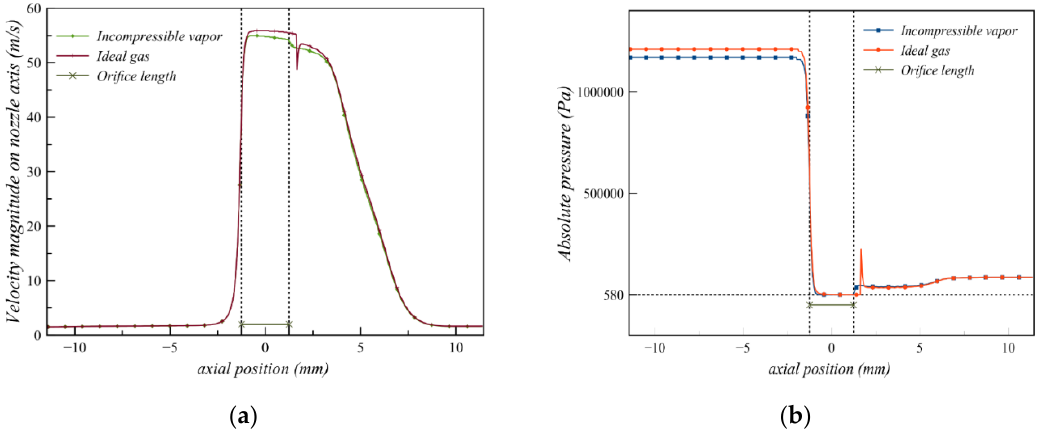
Figure 16. Predicted pressure and velocity profiles on the nozzle axis. ( a ) Pressure profile, ( b ) velocity profile. To further investigate the formation of the shockwave, local sonic speeds in the liquid phase, , the vapor phase, , and the mixture phase (cavitation region), and the flow velocity magnitude 𝑎𝑎 𝑙𝑙 𝑎𝑎 𝑣𝑣 𝑎𝑎 𝑚𝑚 on the nozzle axis are plotted in Figure 17, which show that local sonic speed in the mixture phase is substantially reduced and becomes significantly smaller than the flow velocity within the nozzle orifice region ) and up to a distance from the nozzle exit. Figure 17 also indicates that local sonic speed in the mixture phase becomes considerably lower ( − 1.3 𝐷𝐷 < 𝑥𝑥 < 2.5 𝐷𝐷 0.75 𝐷𝐷 (or 𝑥𝑥 = 3.25 𝐷𝐷 ) than local sonic speeds of vapor and liquid phases, implying that the local flow in the mixture phase becomes supersonic in the cavitation region. Downstream of the cavitation region at (or 1.63 mm), the fluid transforms back to the liquid state because of the higher local pressure (Figure 𝑥𝑥 = 3.25 𝐷𝐷 15b and Figure 16a). Thus, the local flow becomes subsonic from supersonic and hence, as a consequence, a normal shockwave is formed.